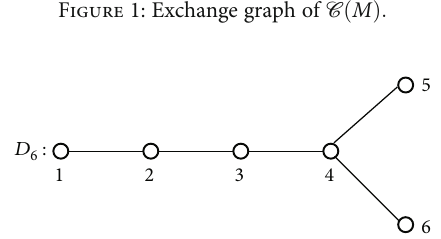
Figure 1: Exchange graph of C ð M Þ :